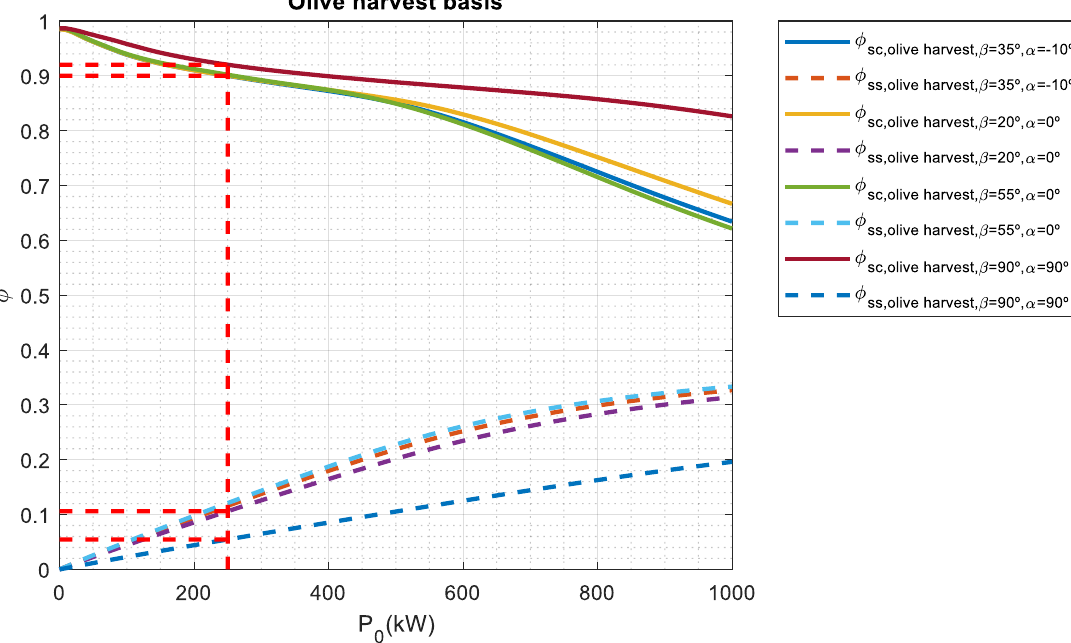
Figure 10. Olive harvest basis. Self-consumption and self-sufficiency curves as a function of P 0 .